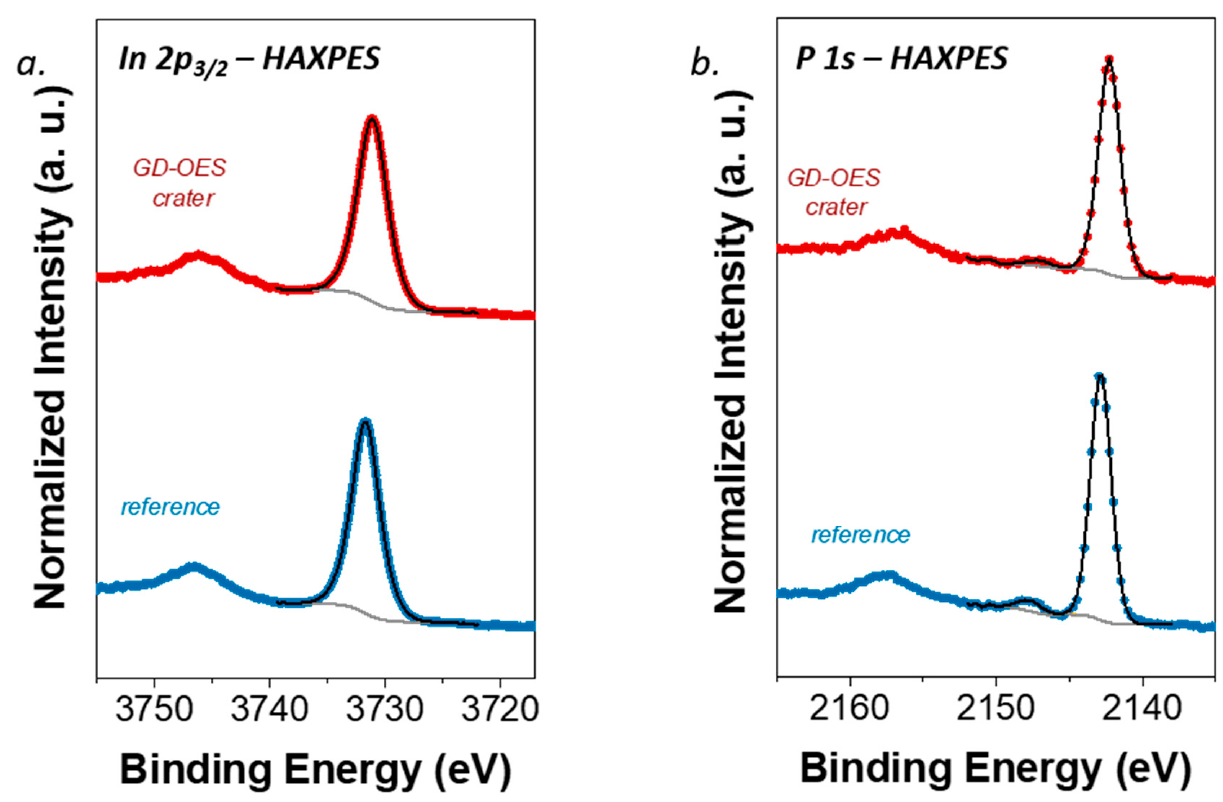
Figure 4. High energy resolution spectra for the InP surface outside (blue, bottom spectra) and inside (red, top spectra) the GD-OES crater, In 2p 3/2 ( a ) and P 1s ( b ) with the Ga-K α (9.25 keV) source.